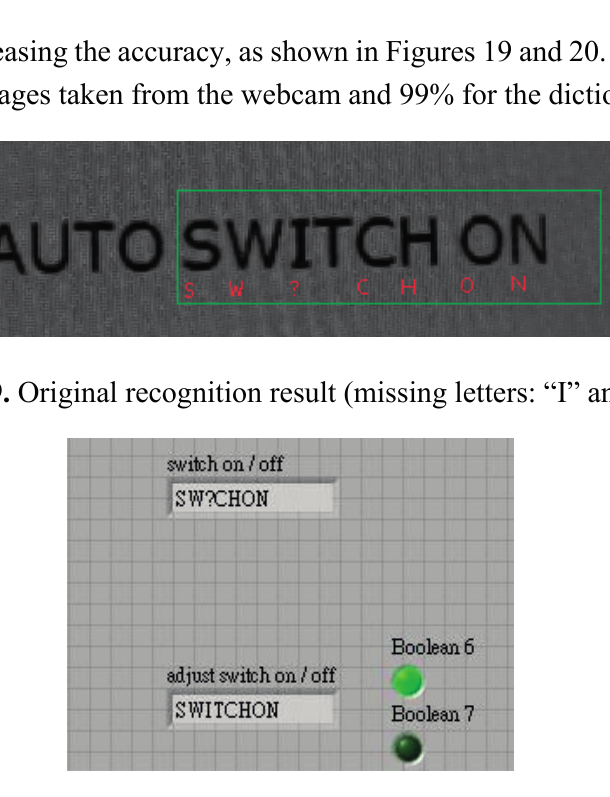
Figure 20. Corrected by a dictionary process.